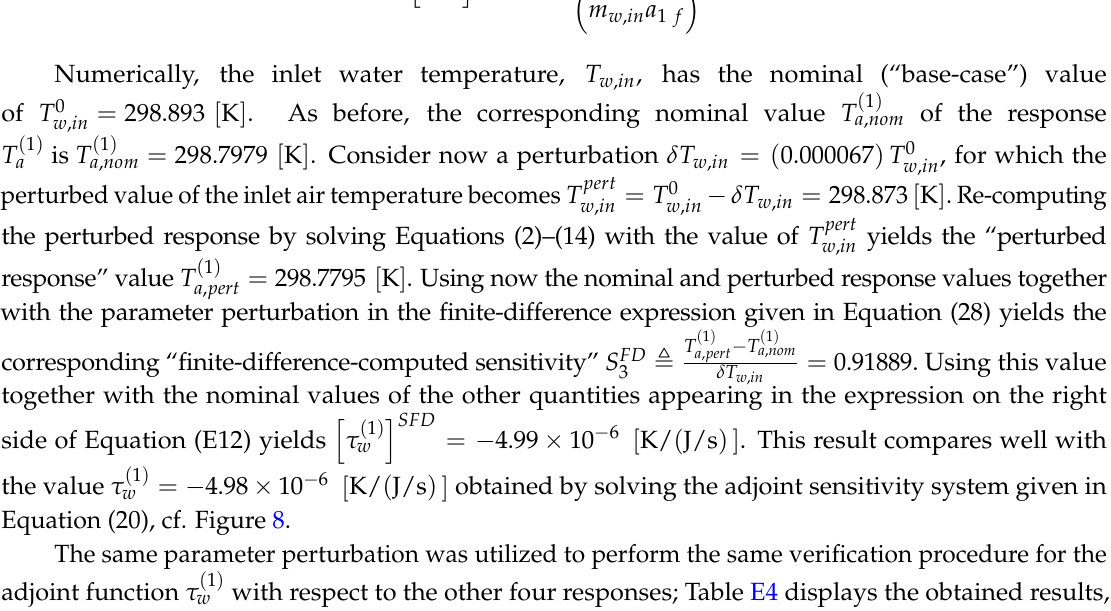
( 1 ) w with respect to the responses T